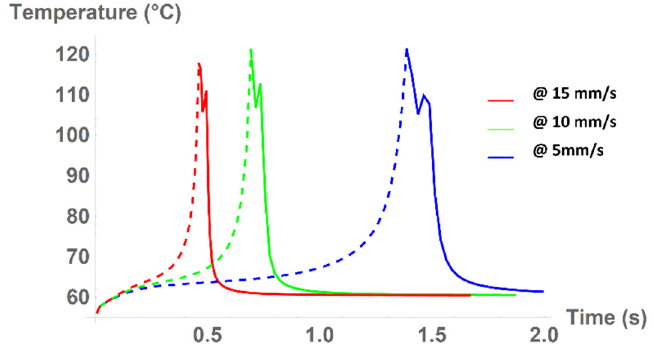
Figure 8. Temperature of the fixed-point during printing.